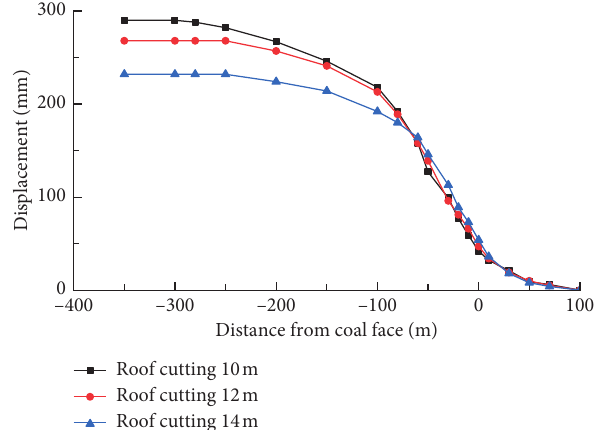
Figure 18: Deformation of the roof and floor of the roadway.